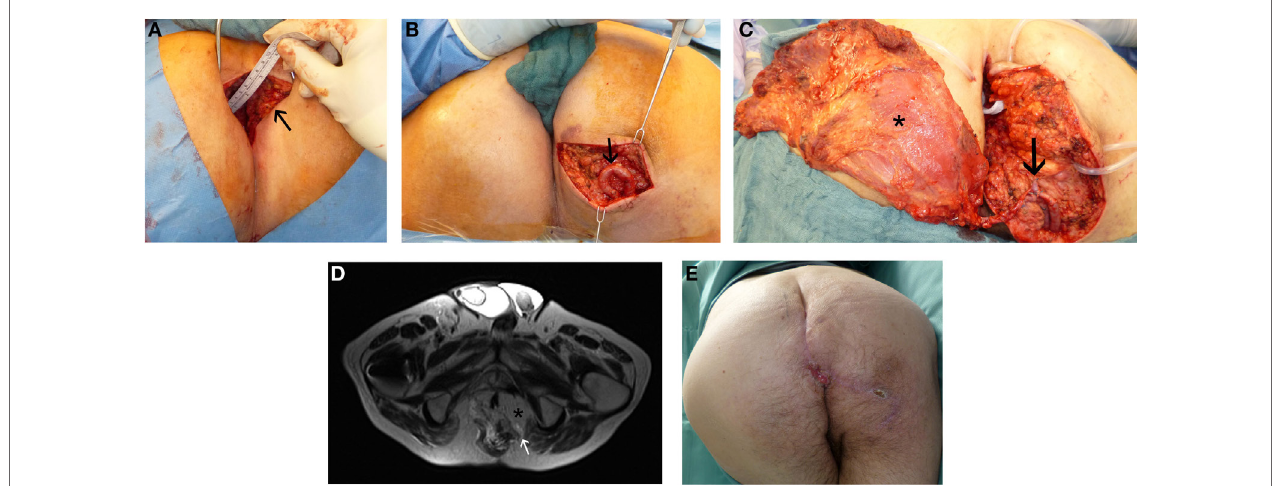
FiGURe 3 | Perineal defect reconstruction after resection of a chronic sacral cavity with fistulas using a microsurgical free “buried” latissimus dorsi flap and an arterio-venous loop . In history, after radio-chemotherapy a rectal carcinoma had been resected. (A) Preoperative presentation of chronic sacral fistula (black arrow). (B) Situs after dissection of the arterio-venous loop (black arrow). (C) Intraoperative view at anastomosed latissimus dorsi flap (black asterisk) at the loop (black arrow). (D) MR-Angiography with microsurgical free “buried” latissimus dorsi flap (black asterisk) inserted to reconstruct perineal defect and imaging of the consistent arterio-venous loop (white arrow). (e) Result 1 month